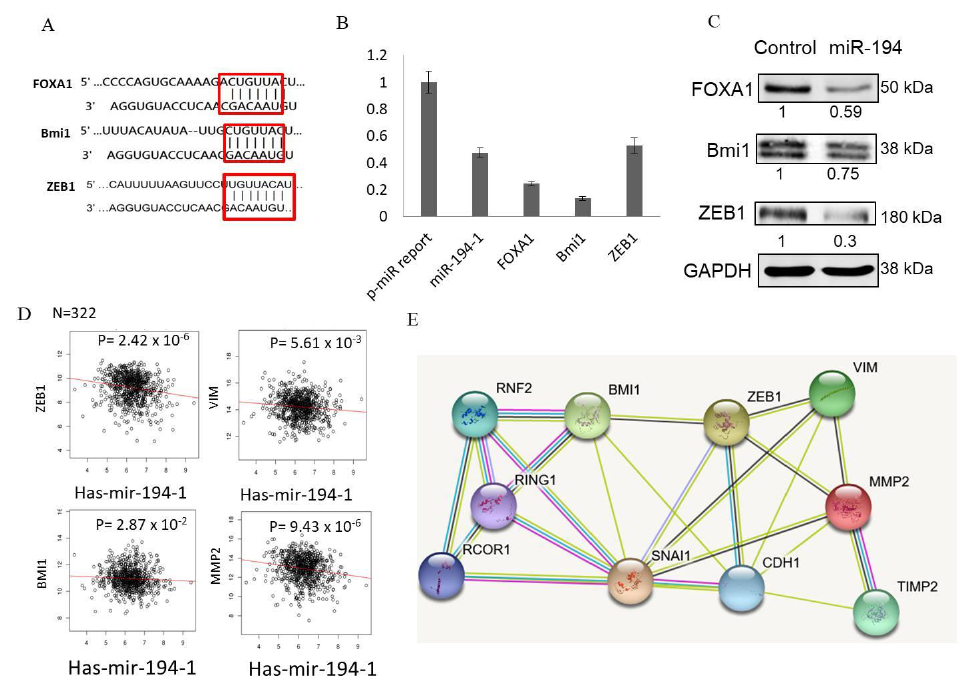
Figure 6. Negative correlation of miR-194-5p and EMT-associated genes in breast cancer cells. The target relationships between miR-194-5p and FOXA1, Bmi1, and ZEB1. ( A ) The target genes were predicted by the TargetScan database. The seed sequence of miR-194-5p and target binding sites were shown in the red box. ( B ) Luciferase activity was significantly decreased following co-transfection with pMIR-REPORT-3′UTR- FOXA1, Bmi1, ZEB1, and miR-194-5p in MDA-MB-231 cells. ( C ) Over-expression of miR-194-5p may down-regulate the protein expression levels of FOXA1, Bmi1, and ZEB1 in MDA-MB-231 cells. ( D ) Graphs showing the levels of miR-194-5p versus ZEB1, VIM, and MMP2 in 322 tumors from the TCGA breast cancer cohort. p -values were calculated using Pearson correlation tests. RPKM: Reads per kilobase per million mapped reads. ( E ) STRING-DB analysis shows that differentially expressed proteins participate in metastasis. ZEB1 and BMI1 are two major hubs in the network; colored nodes indicate query proteins; lines connected with colored nodes represent an interaction between two query proteins; different colored lines indicate information from different resources; blue lines denote data analyses from curated databases; pink lines denote data analyses from determined experiments; yellow lines denote data analyses from text mining; and black lines represent pairs of co-expressed proteins.